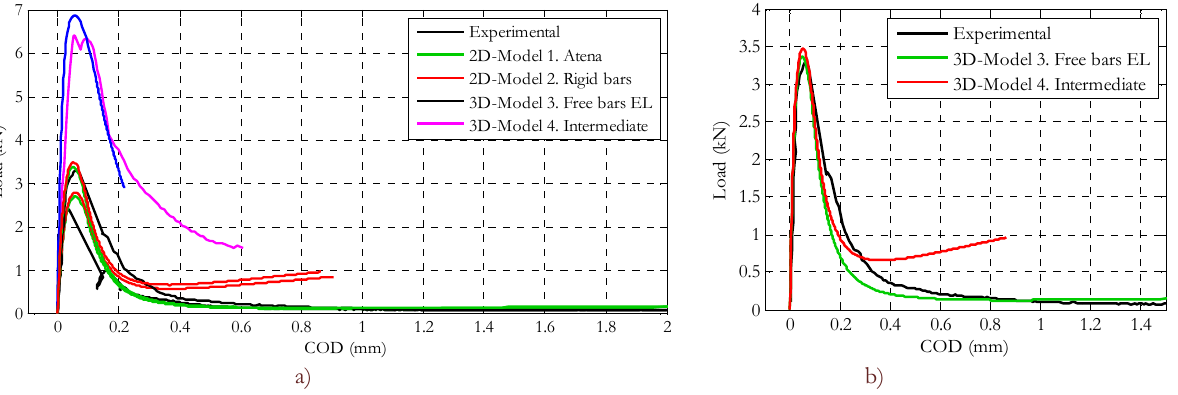
Figure 9: Load-COD curves for specimen 2: a) all modes including 2D model, and b) zoom detailing only 3D models and experimental